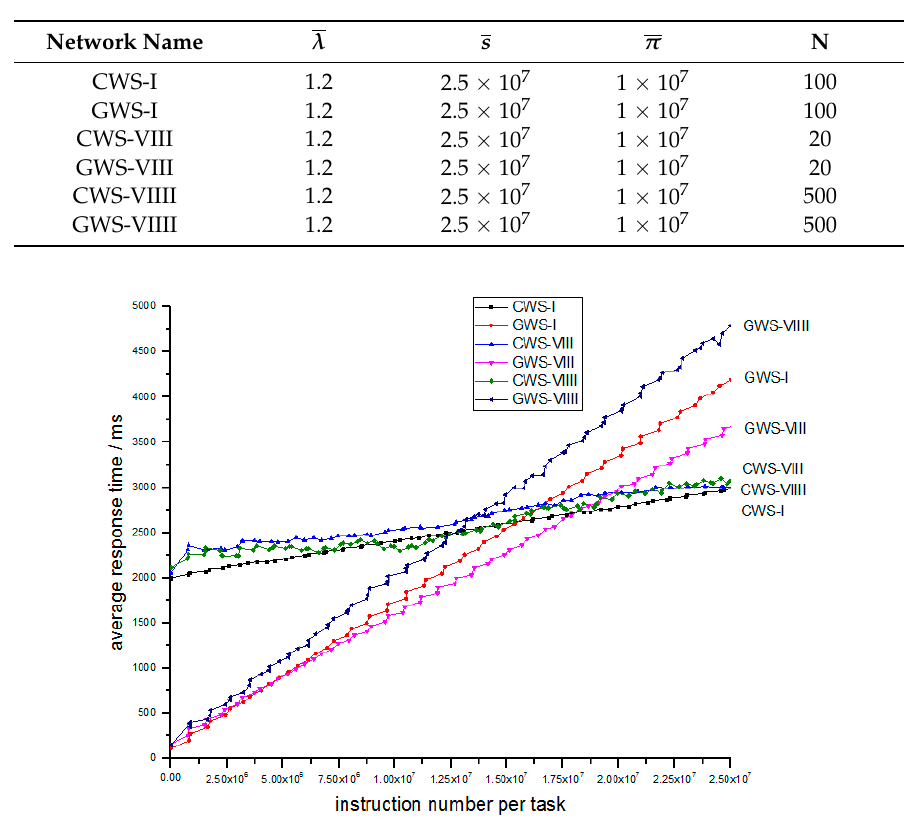
Figure 13. The relation of average response time and number of instructions per task between different average instruction number per task.